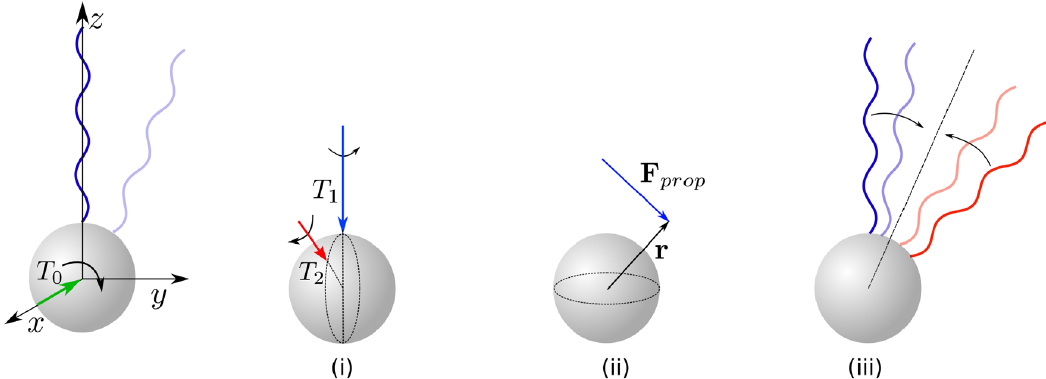
Fig 10. A sketch of possible reorientation mechanisms. Left: rotation of the cell body due to applied torque T 0 in x direction; the light filament represents the position of the flagellum after the rotation. Right, case (i): a cell body subject to two point torques; case (ii): a cell body subject to a force F applied at location r relative to the cell centre; case (iii): two flagellar filaments joining at a prop given axis.